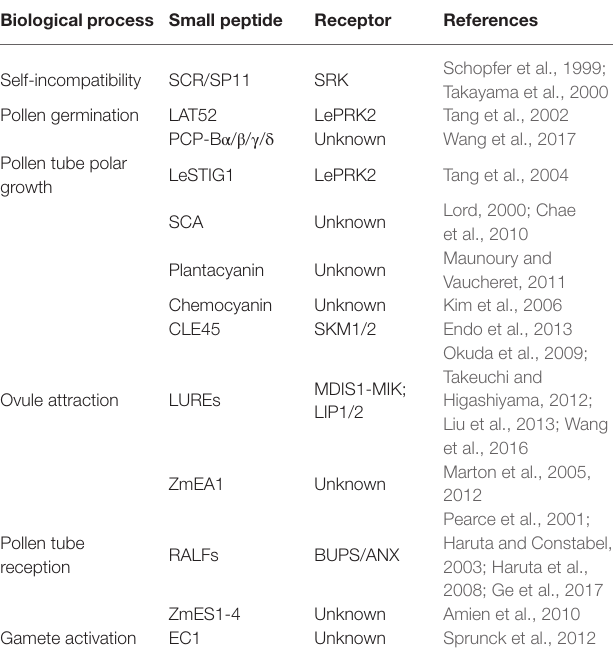
TABLE 1 | Peptides and receptors involved in double